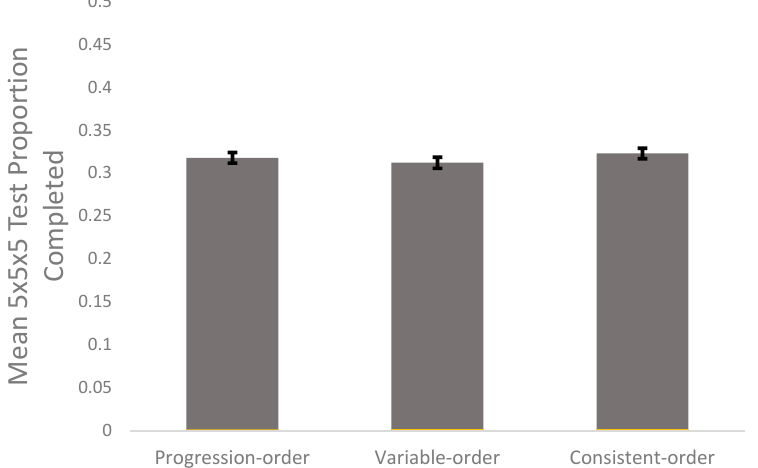
Figure 4. The 5 × 5 × 5 Rubik’s Cube mean completion in the progression-order ( n = 44), consistent-order ( n = 45), and variable-order ( n = 44) groups. Error bars represent standard errors of the mean.